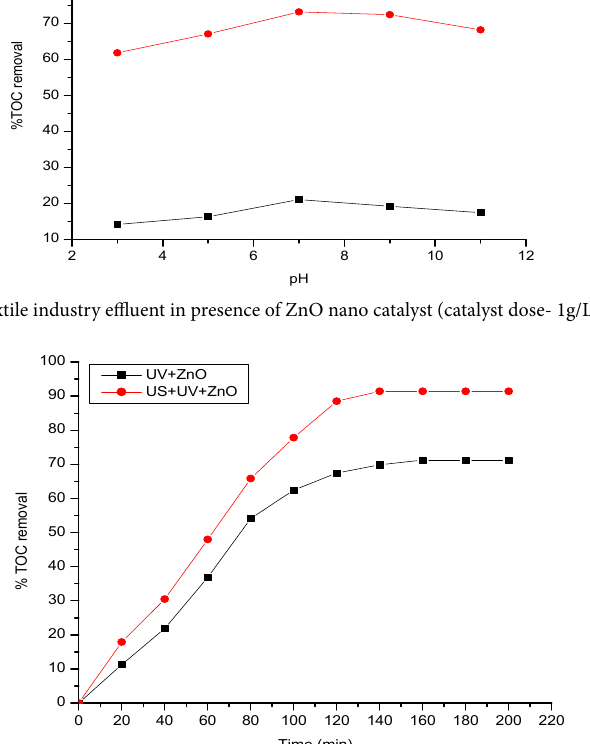
Fig. 4. Effect of contact time on % TOC removal efficiency of textile industry effluent (catalyst dose 1 g/L and pH 7) Fig.4.Effect of contact time on % TOC removal efficiencyof textile industry effluent(catalyst dose 1 g/L and pH Fig. 4. The equilibrium time for % TOC removal in to be 160 min. at pH 3. On the basis of % TOC values, as initially as contact time increases % TOC removal also increases rapidly, though it increases slowly after 160 min.